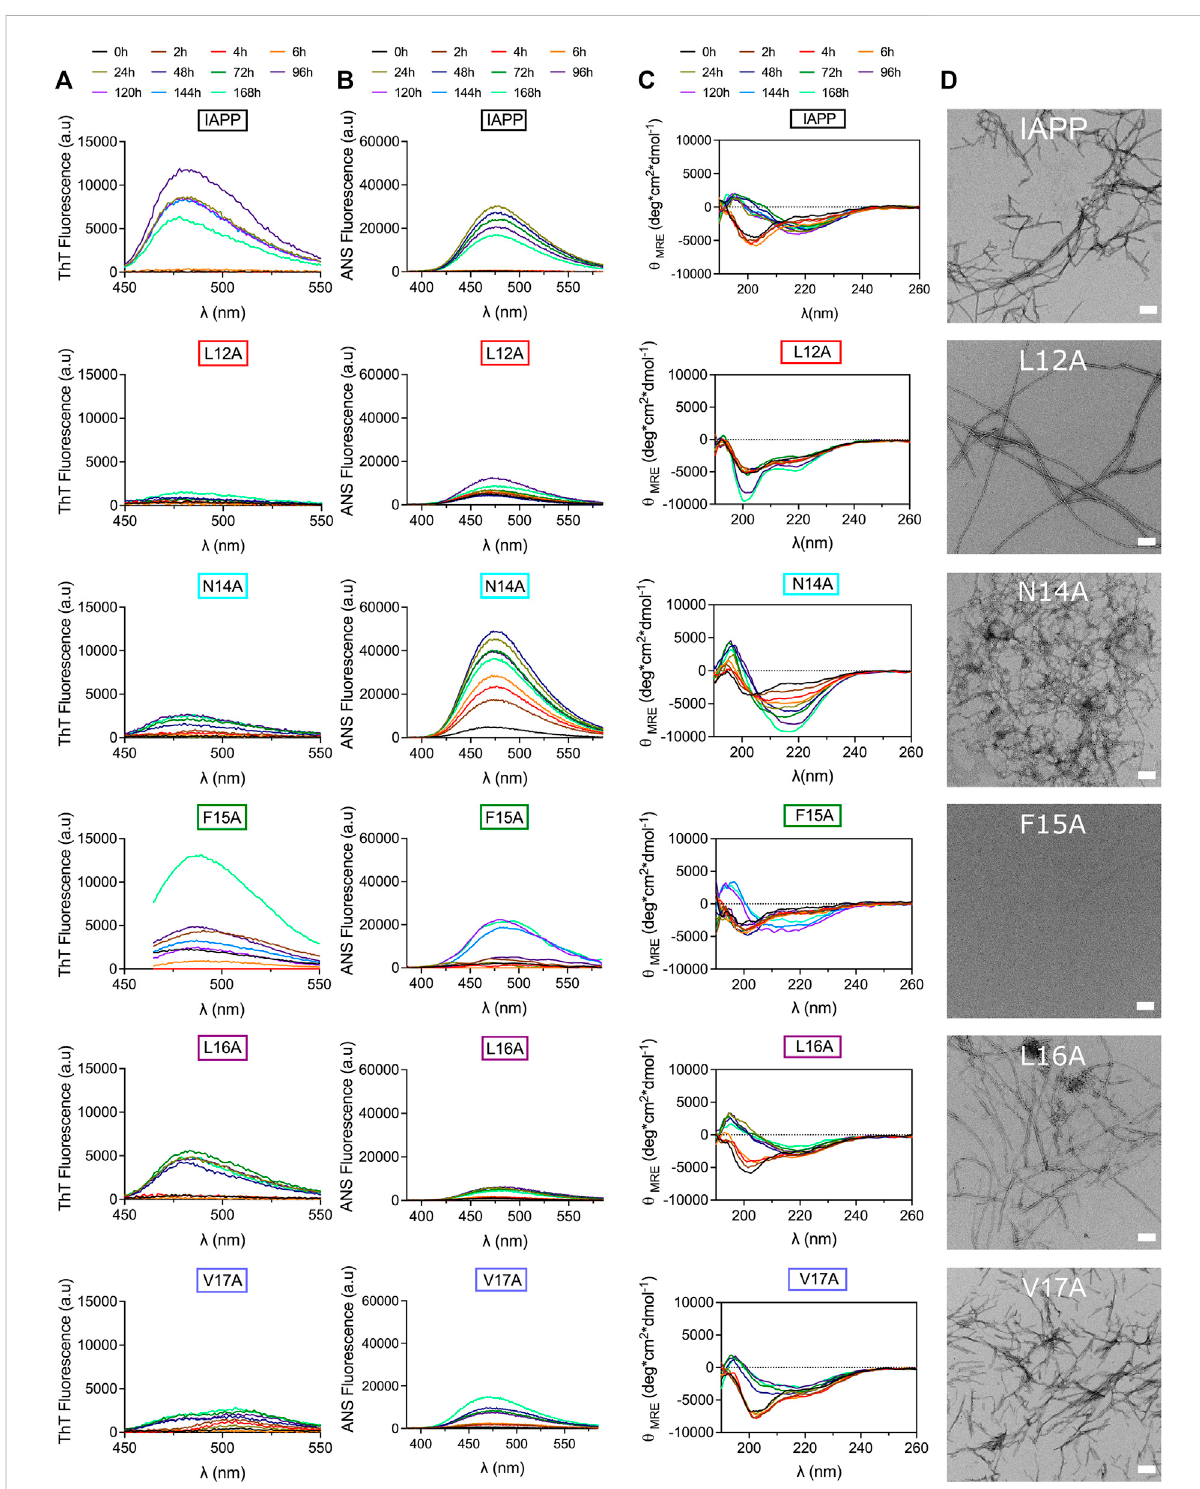
FIGURE 4 Effect of Ala-substitution within the 12 – 17 segment of IAPP on amyloid formation. (A – D) Peptides were incubated at 50 μ M under fully quiescent conditions in 20 mM Tris-HCl buffer, pH 7.4, and periodically analysed by (A) ThT fl uorescence, (B) ANS fl uorescence, and (C) CD spectroscopy. (D) TEM images after 48 h incubation. Scale bar: 100